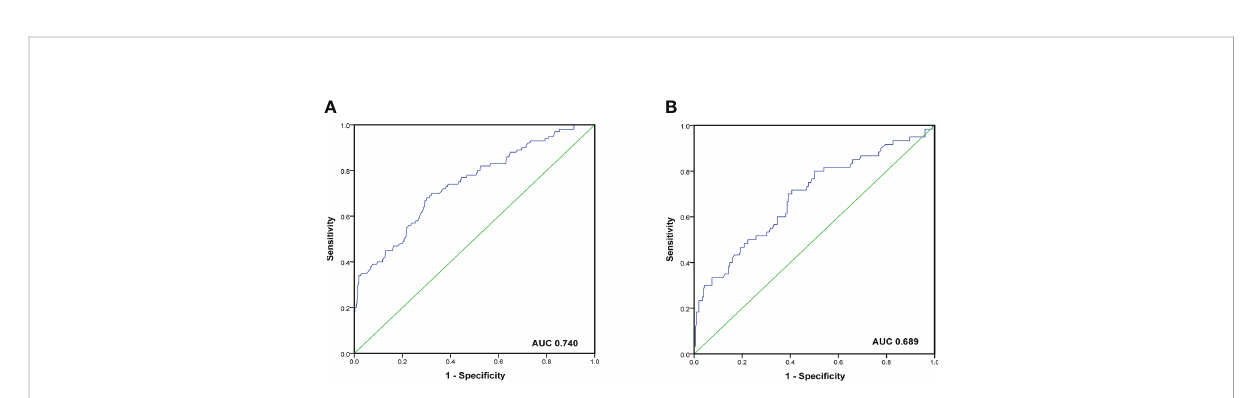
FIGURE 6 ROC curve and the area under the curves of ROC curves in the training cohort (A) and validation cohort (B)